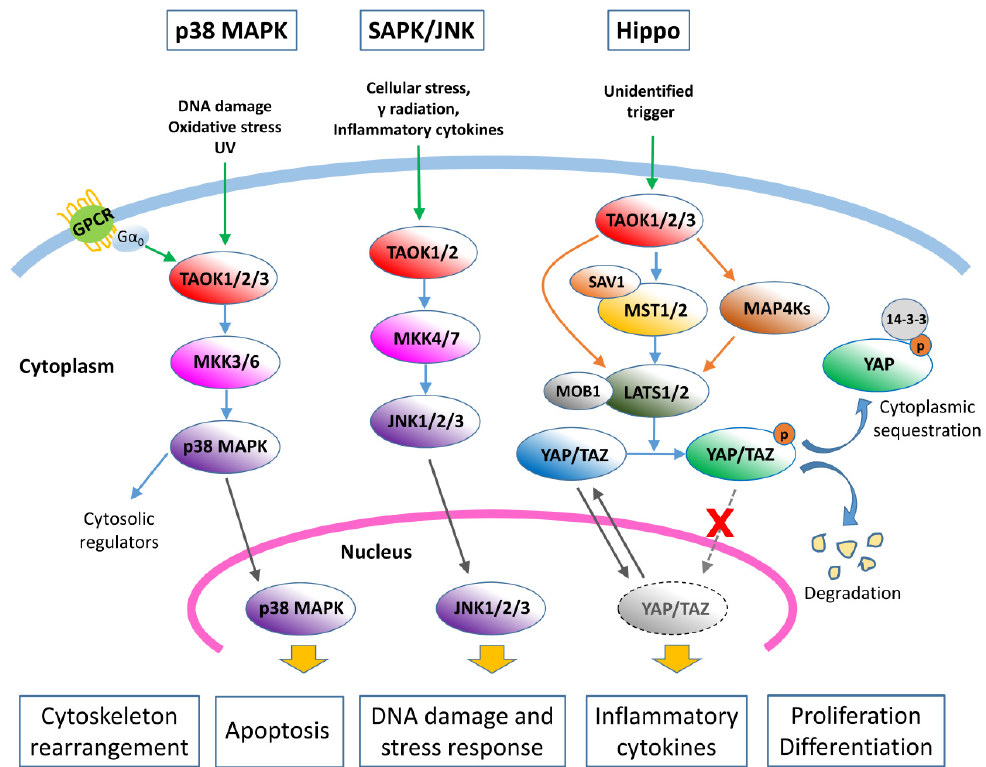
Figure 2. Kinase cascades regulated by TAOK1/2/3. TAO kinases are involved in p38 MAPK, SAPK/JNK, and Hippo signaling pathways. GPCR: G protein-coupled receptor; SAV1: Salvador 1. Green arrows: upstream stimuli; blue arrows: typical/canonical pathways; orange arrows: alternative pathways in the Hippo cascades; grey arrows: nuclear translocation/exportation.